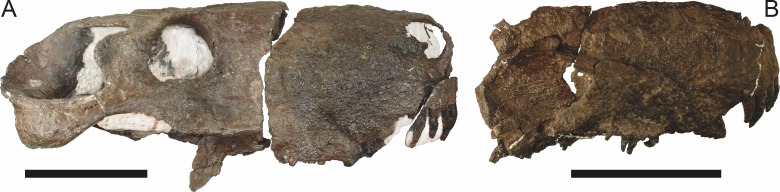
Referred specimens of Sycosaurus nowaki (Broili & Schröder, 1936).(A) UMZC T889 in left lateral view (flipped for comparative purposes). (B) snout of UMZC T877 in right lateral view. Scale bars equal 10 cm.